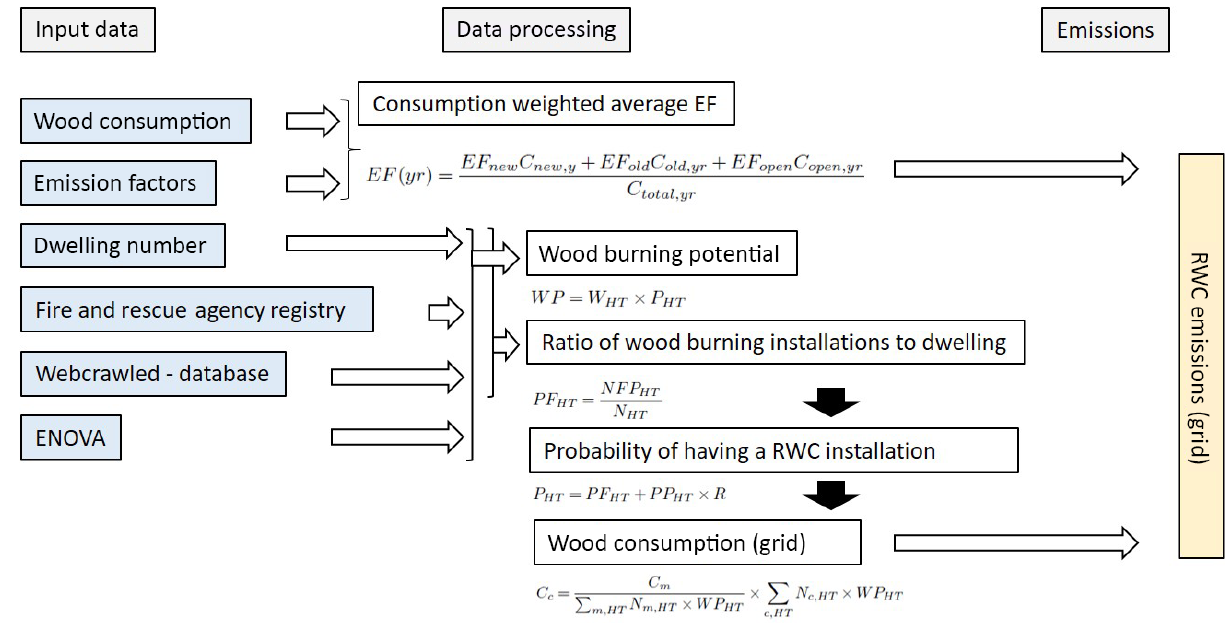
Figure 1. Schematic representation of the data flow and calculations done in MetVed.